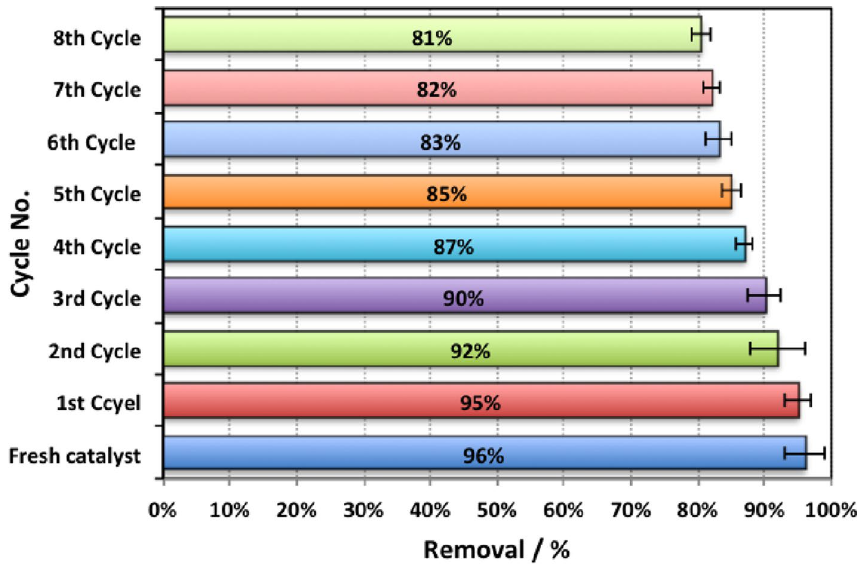
Fig. 11 Reusability